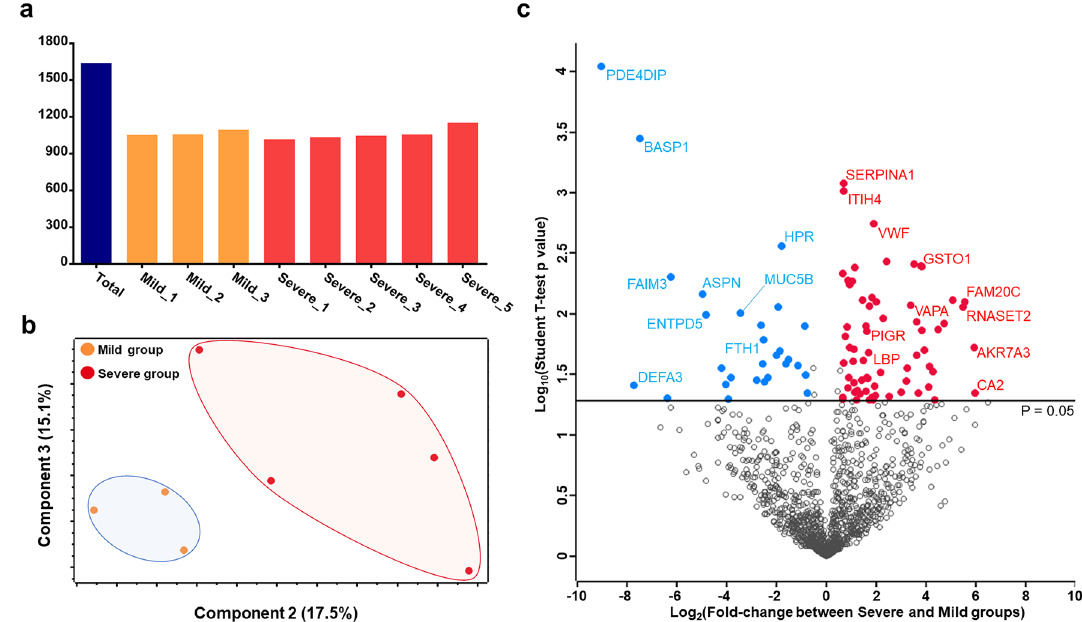
Figure 2. Plasma proteome data generated using COVID-19 infected patients. ( a ) The number of proteins identified in each plasma sample as well as the number of total identifications is plotted. ( b ) The result of principle component analysis (PCA) is depicted as 2-dimensional diagram. ( c ) The log-transformed student’s t-test p value of each protein is plotted against the log-transformed fold-change. The middle line indicates the p value cut-off, 0.05. The proteins with high significance (top eight) were labeled.